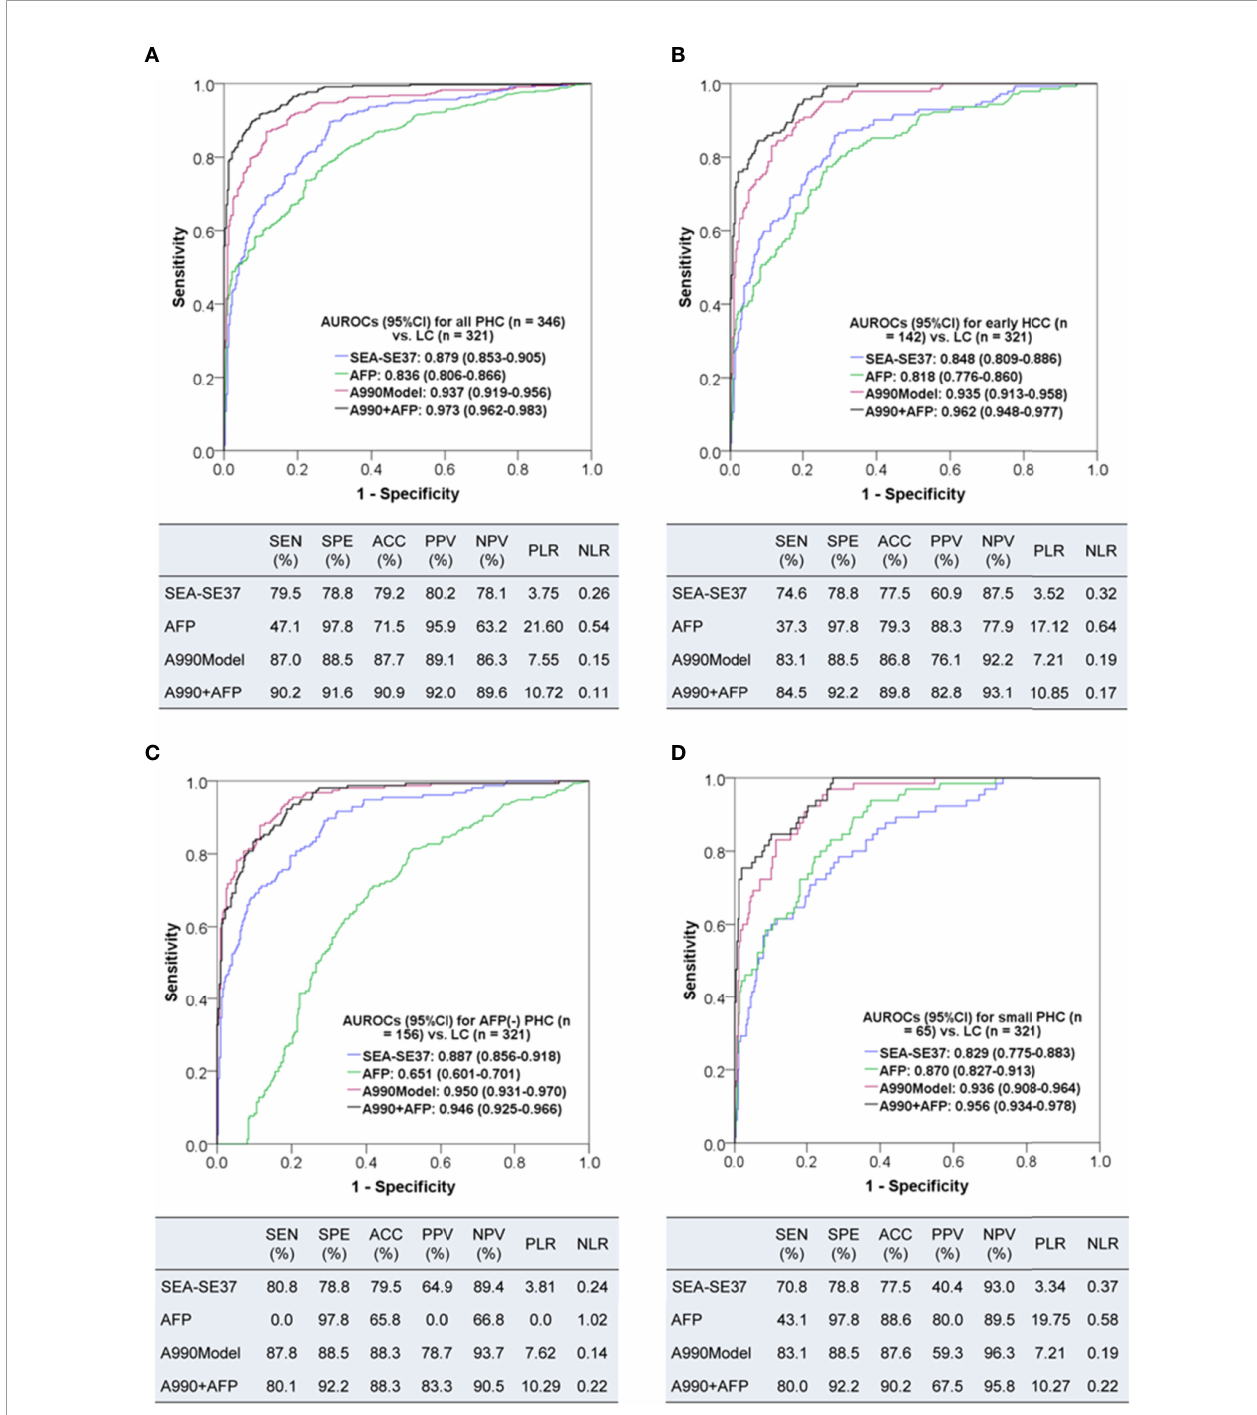
FIGURE 5 | The diagnostic performances of triple serum fl uorescence intensity of aptamer AP-HCS-9-90 alone and in combination for primary hepatic carcinoma. (A – D) : Diagnostic performances for all patients, early HCC (BCLC stage A), AFP-negative (< 20 ng/mL) PHC, and small (<= 3 cm) PHC, respectively. AUROC, area under the receiver operator characteristic curve; CI, con fi dence interval; PHC, primary hepatic carcinoma; LC, liver cirrhosis; HCC, hepatocellular carcinoma; SEA- SE37, the difference in fl uorescence intensity at 37°C between the serum that was incubated with EvaGreen and aptamer and the serum that reacted with EvaGreen; AFP, alpha-fetoprotein; A990Model, the diagnostic model based on the six original fl uorescence indicators of AP-HCS-9-90; A990+AFP, the diagnostic model based on the six original fl uorescence indicators of AP-HCS-9-90 and AFP; SEN, sensitivity; SPE, speci fi city; ACC, accuracy; PPV, positive predictive value; NPV, negative predictive value; PLR, positive likelihood ratio; NLR, negative likelihood